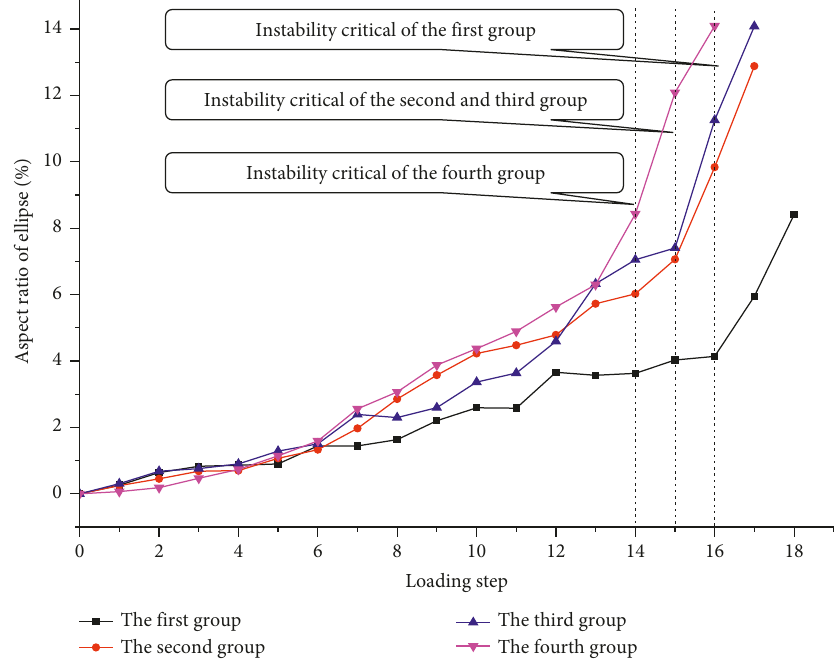
Figure 11: Elliptical aspect ratio for groups of test